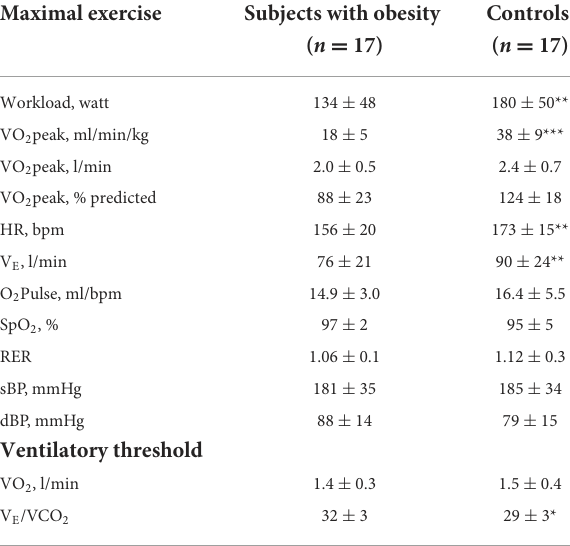
TABLE 4 Cardio-Pulmonary Exercise Tests in subjects with obesity and controls. Maximal